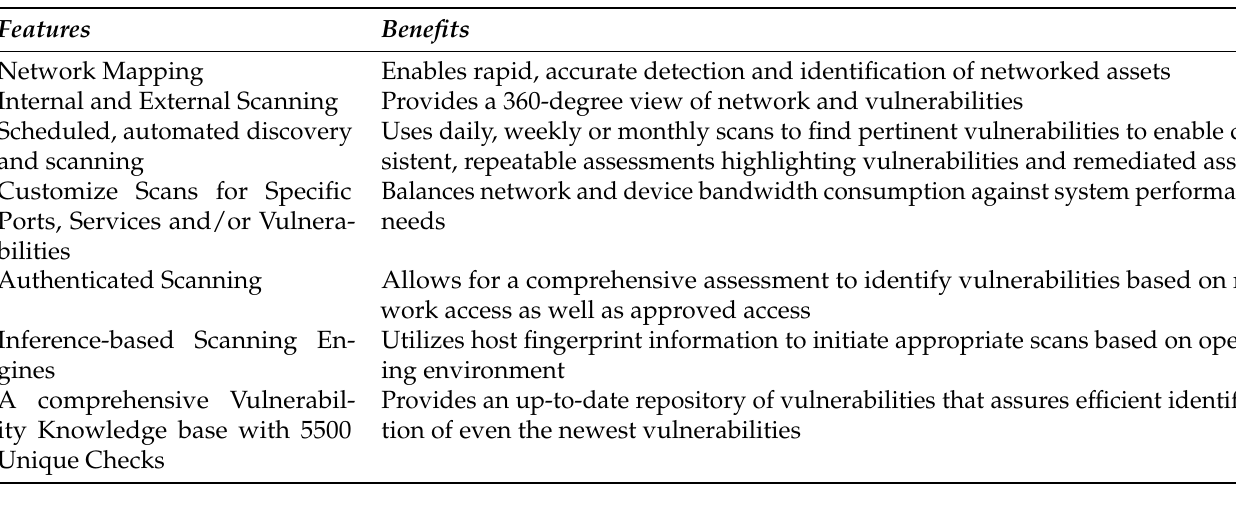
Table 1. VMS Features